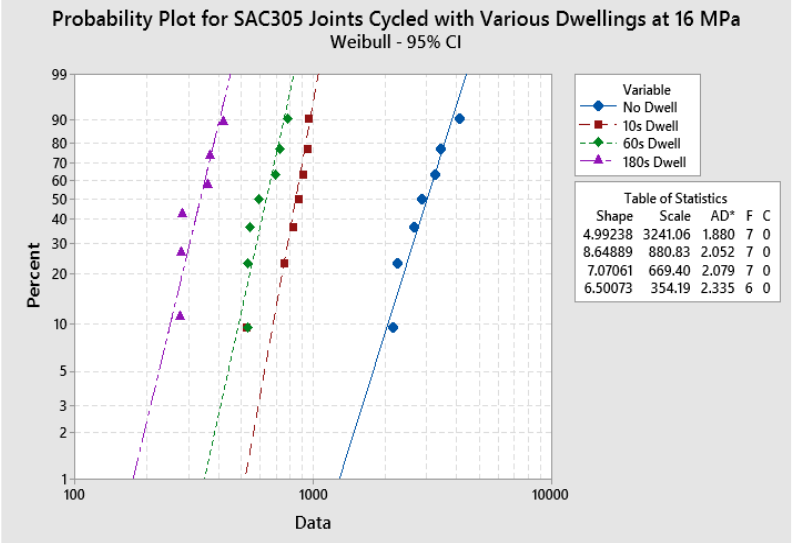
Figure 11. Weibull distributions for SAC305 joints cycled at different dwellings with 16 MPa stress level.